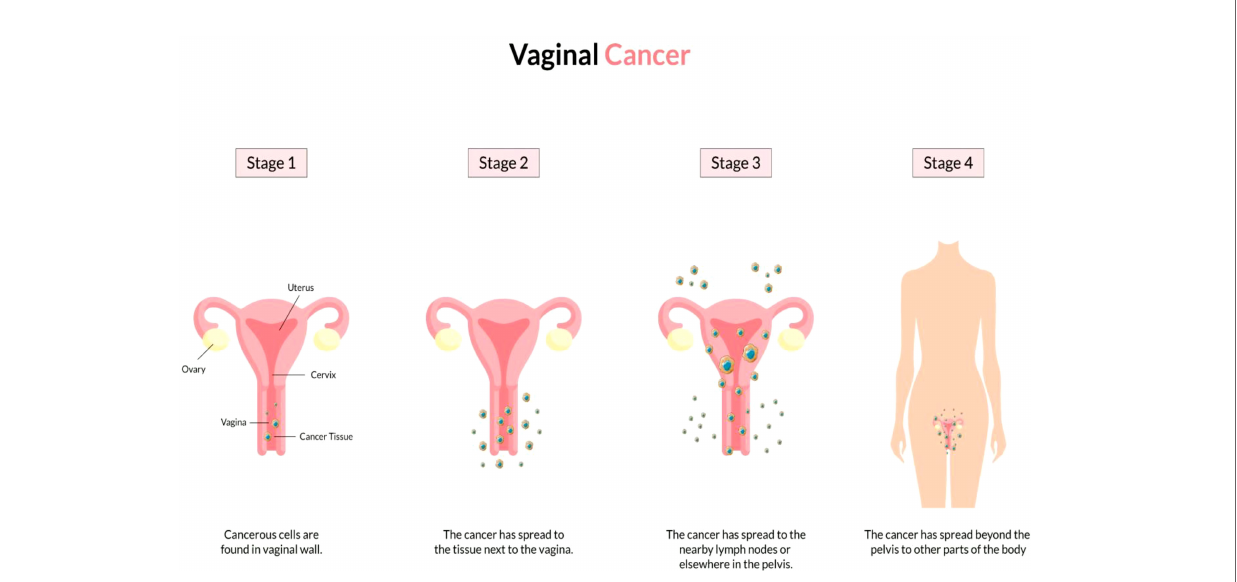
FIGURE 2 | Overview of vaginal cancer and stages. Vaginal cancer is a rare kind of cancer that affects the vaginal area. The cells that line the vaginal surface are the most often affected by vaginal cancer. When found early on, vulvar cancer is generally treatable. Treatment for vaginal cancer that has progressed beyond the vagina is signi fi cantly more challenging. Stage I- Only the vulva or perineum (area between the anus and vulva) have cancerous cells. Stage II- Cancer has progressed to the urethra, anus, or vaginal region. Stage III- The malignancy has progressed to the lymph nodes in the surrounding area. Stage IV- Cancer has spread to other regions of the body from the lymph nodes.